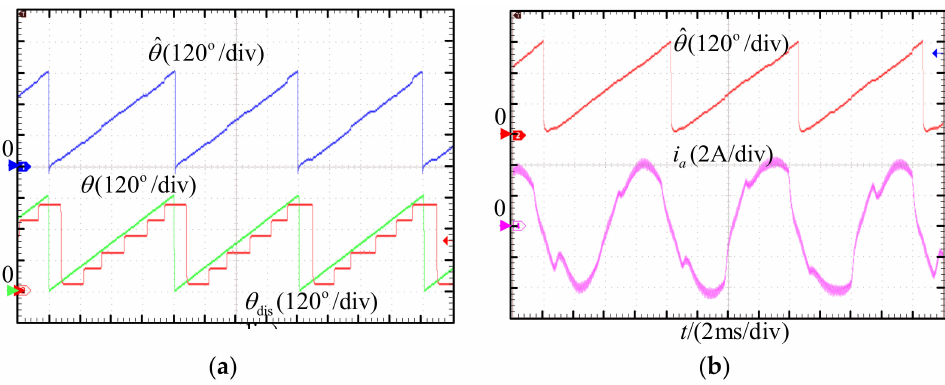
Figure 14. Experimental results of the average speed method. ( a ) Rotor position; ( b ) Phase